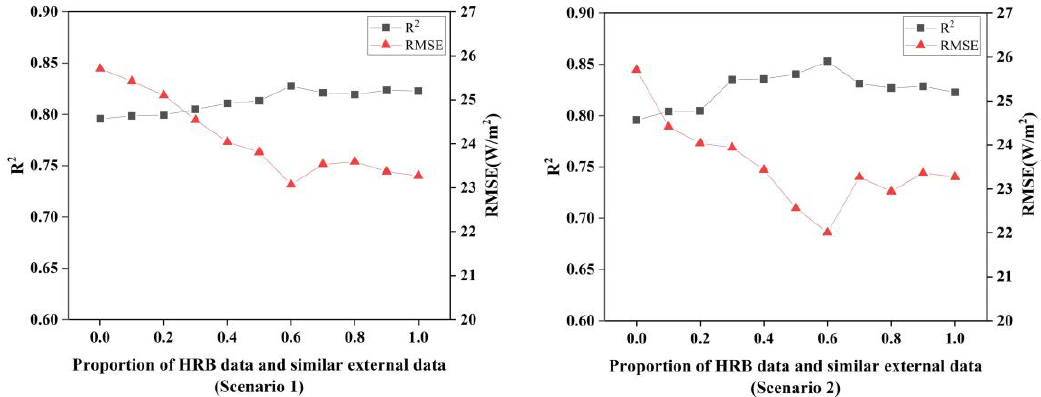
Figure 3. Performance of ANN models in two